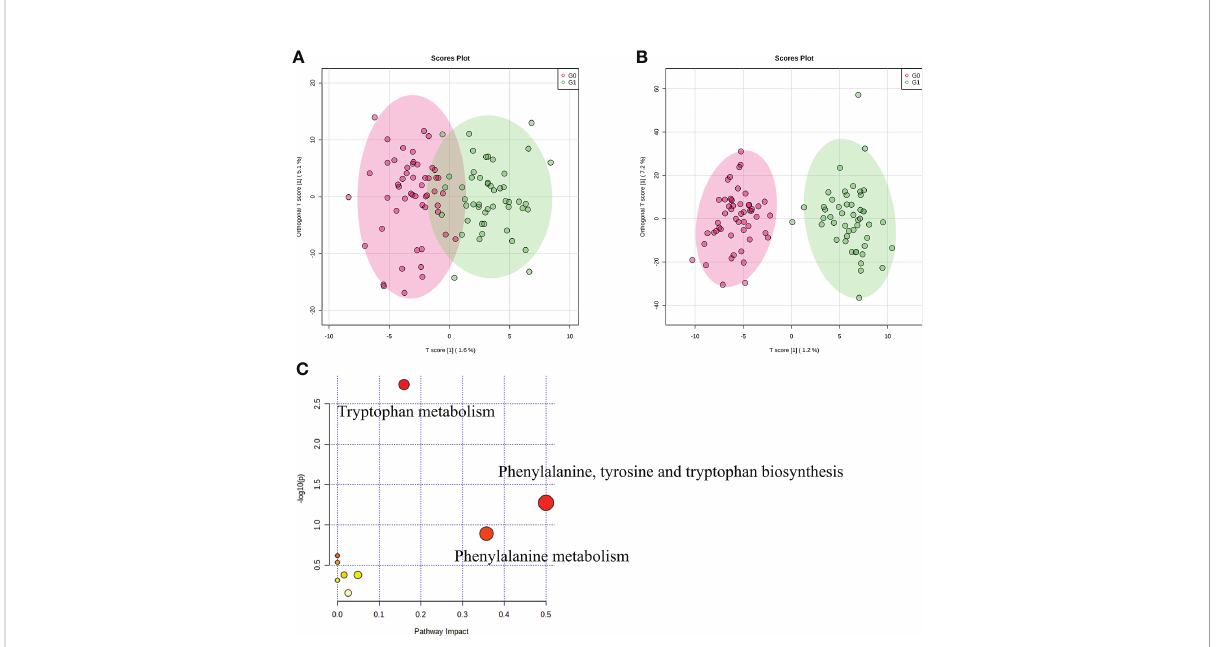
FIGURE 3 Pro fi les of serum metabolites. (A, B) The OPLS − DA score plots of serum samples from T1D patients in (A) negative ion mode and (B) positive ion mode. (C) KEGG pathway enrichment analysis of signi fi cantly altered metabolites. The size and color of each circle were obtained by pathway impact value and p-value,